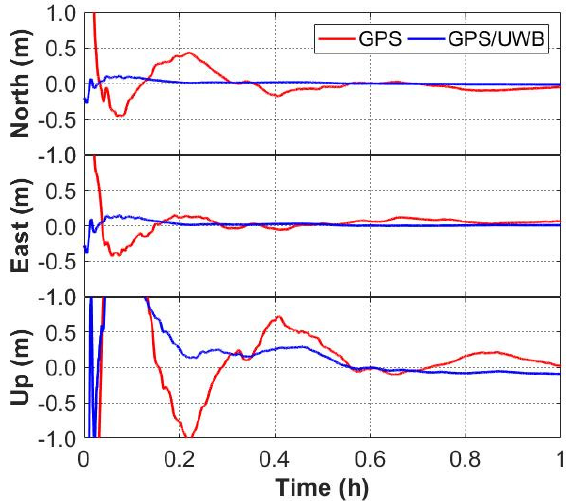
Figure 6. Positioning errors of GPS-only and GPS/UWB solutions.